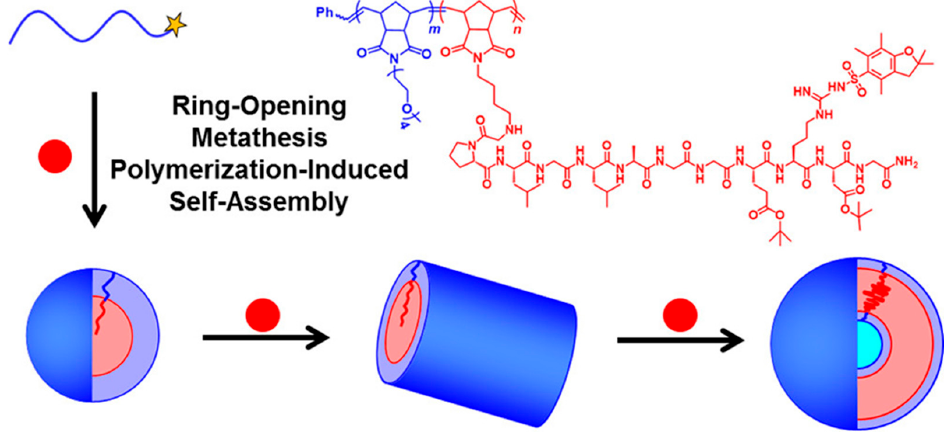
Figure 3. Schematic diagram of ROMPISA conducted using an oligo(ethylene glycol)-based PNB stabilizer block (PNB-OEG, blue) and a peptide-based core-forming norbornene macromonomer (NB-GPLGLAGGERDG, red). Reproduced with permission from reference [72]. Copyright 2017 American Chemical Society.